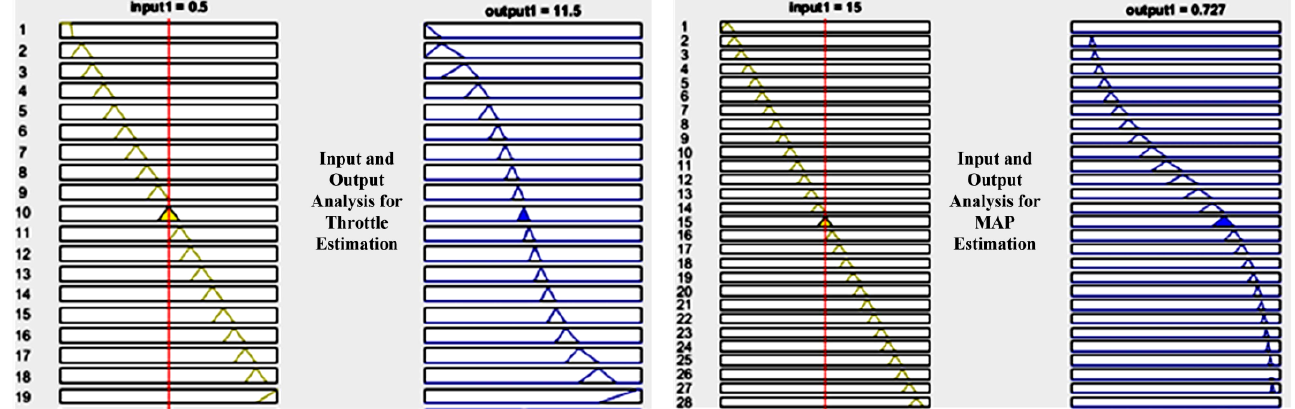
Figure 11. Input and output analysis for MAP and throttle estimation.